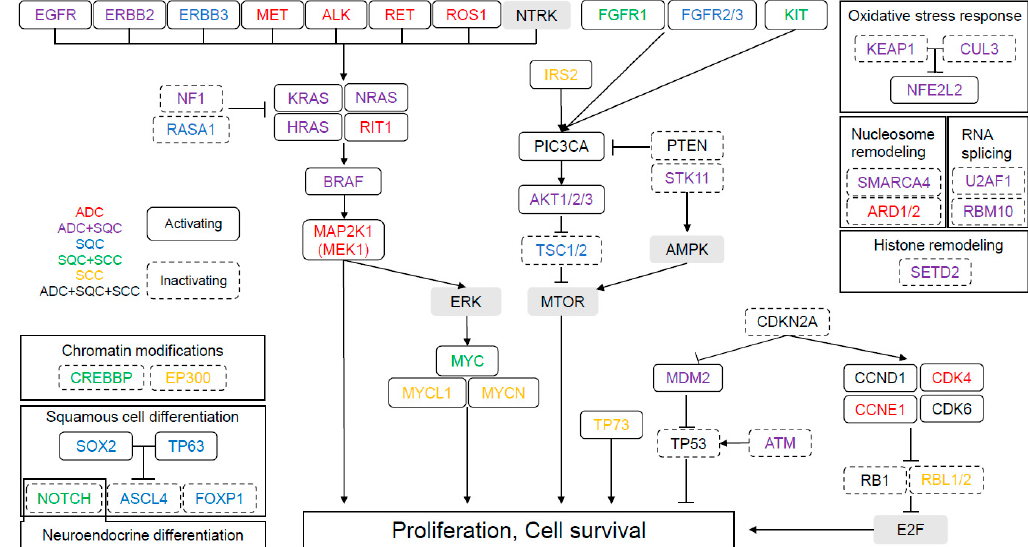
Figure 1. Summary of genetic mutations in lung adenocarcinoma, squamous cell carcinoma, and small cell carcinoma detected by The Cancer Genome Atlas project. [3–5].